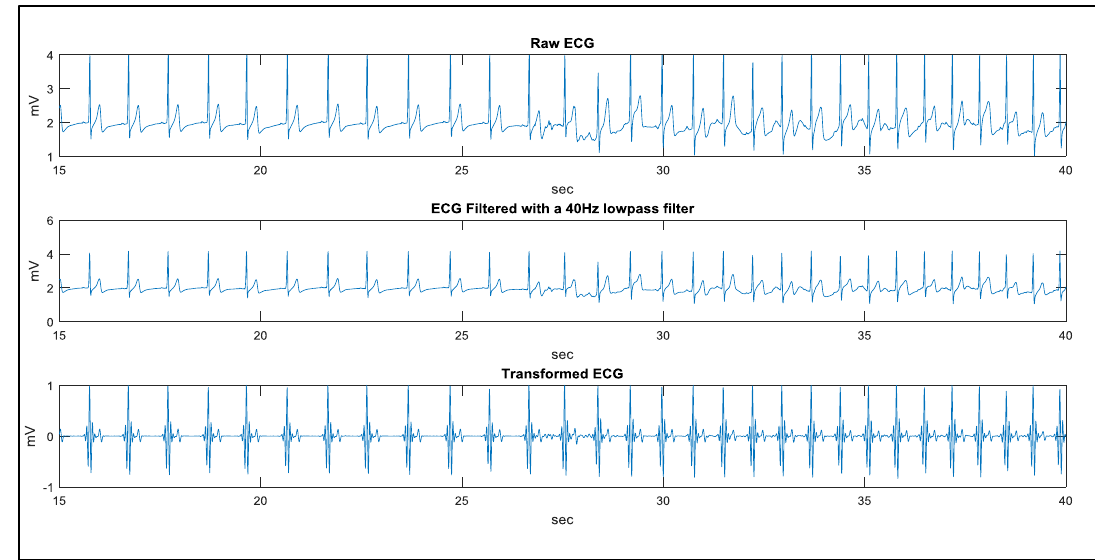
Figure 19. The signal processing results from 15 to 40 s.